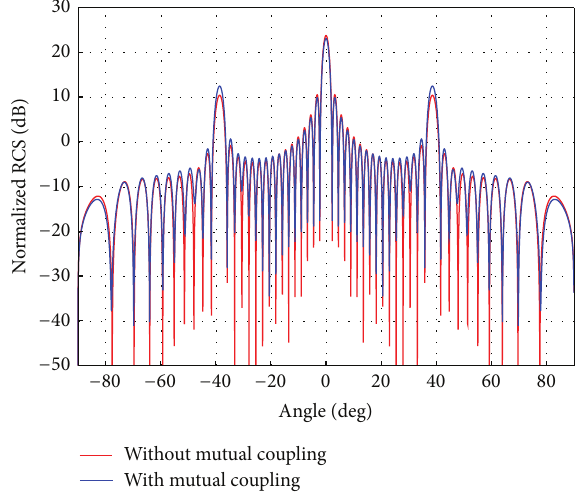
Figure 17: Broadside RCS of a parallel-fed 32-element linear dipole array in side-by-side